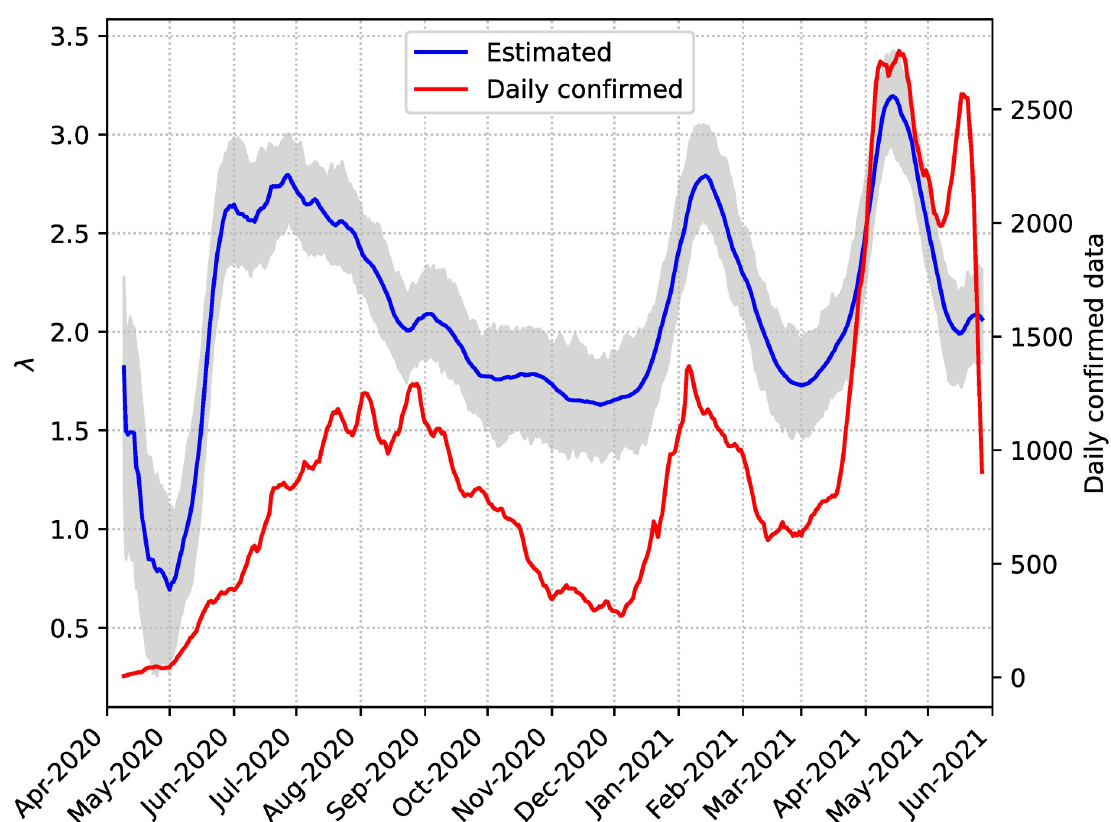
Fig 11. Estimations of λ . The estimated values are shown with a solid blue line and ensemble members with gray lines. The red line corresponds to the 7-day rolling average of daily confirmed cases.